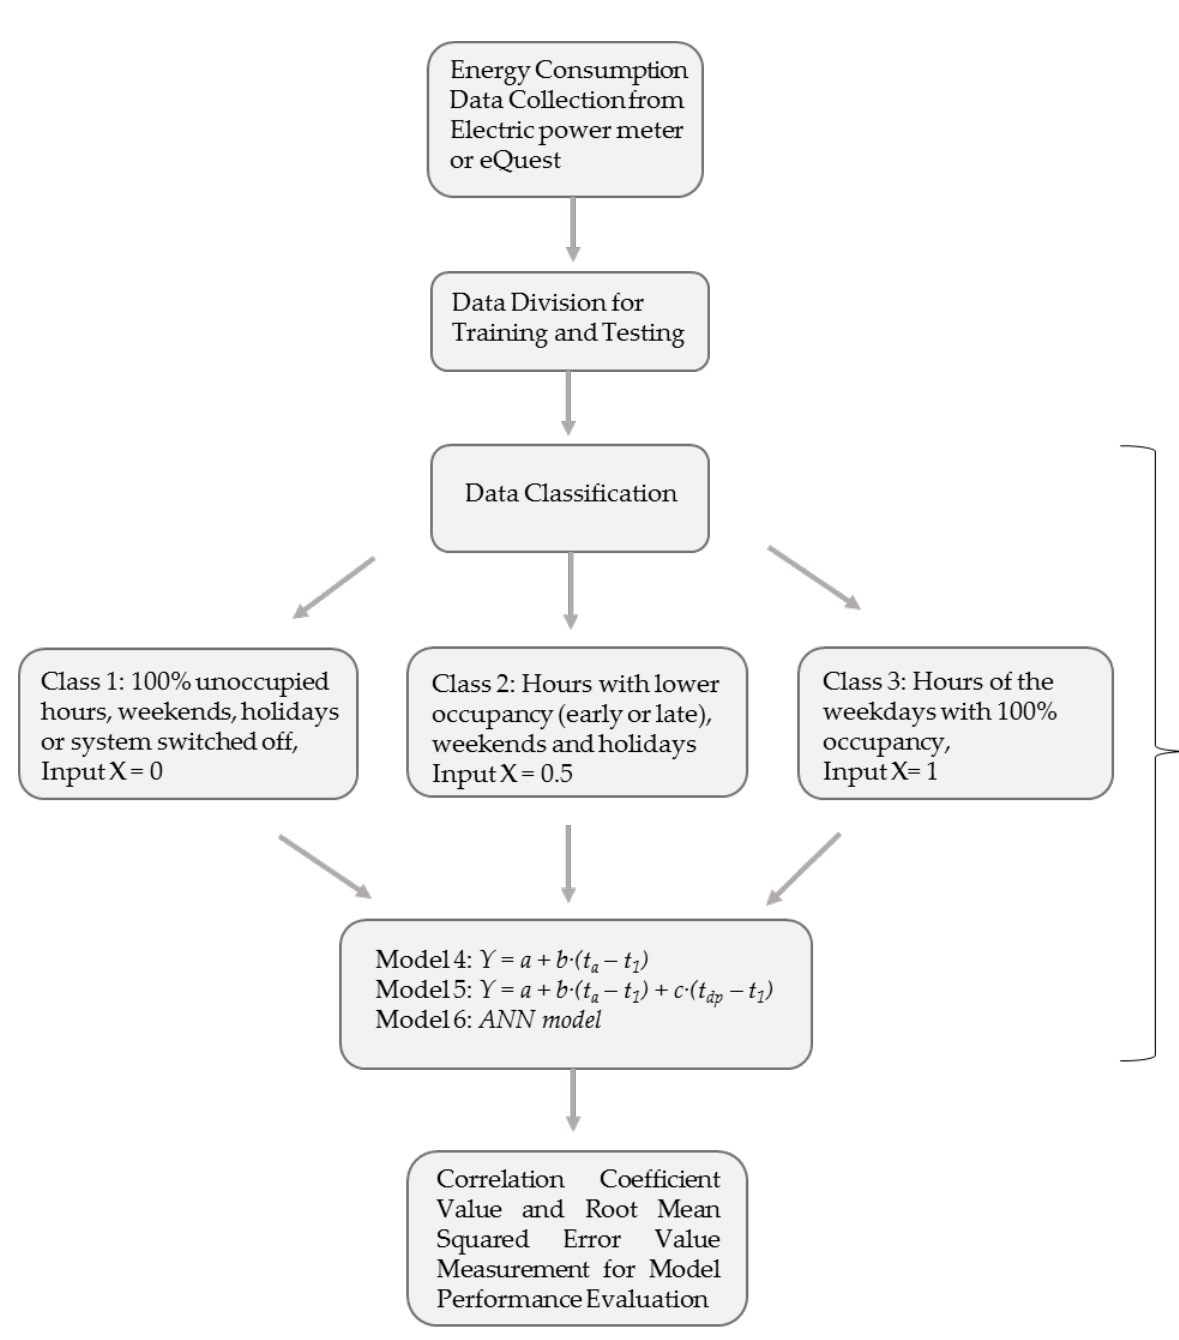
Figure 1. Flowchart for the methodology of proposed